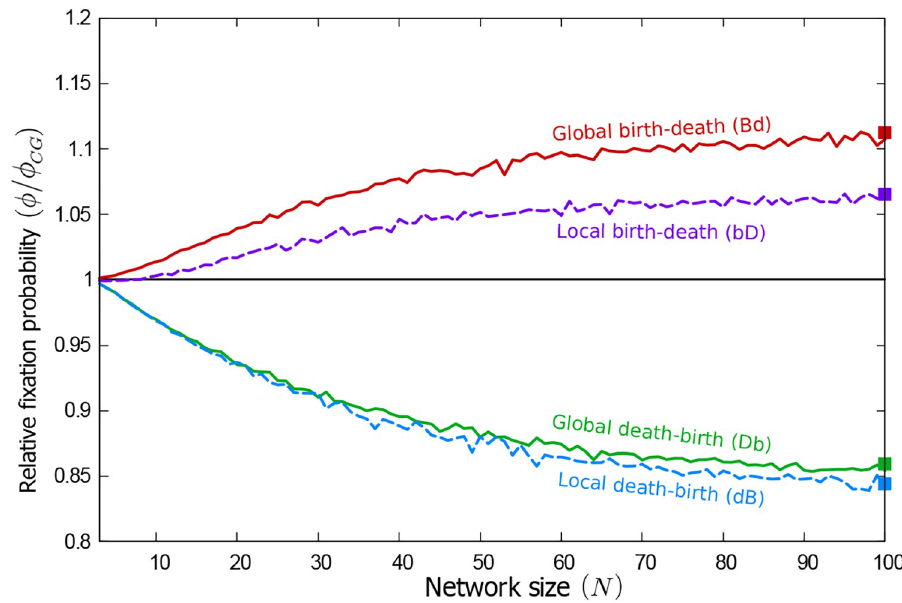
Fig 3. Fixed heterogeneous graphs amplify selection for birth-death processes and suppress it for death-birth processes. The figure shows the fixation probability of an invading mutant ( ϕ ), averaged over static CRGGs. Data is shown relative to the corresponding fixation probability on a complete graph ( ϕ CG ). Regardless of the population size, selection is amplified for Bd and bD processes, and suppressed for Db and dB processes.